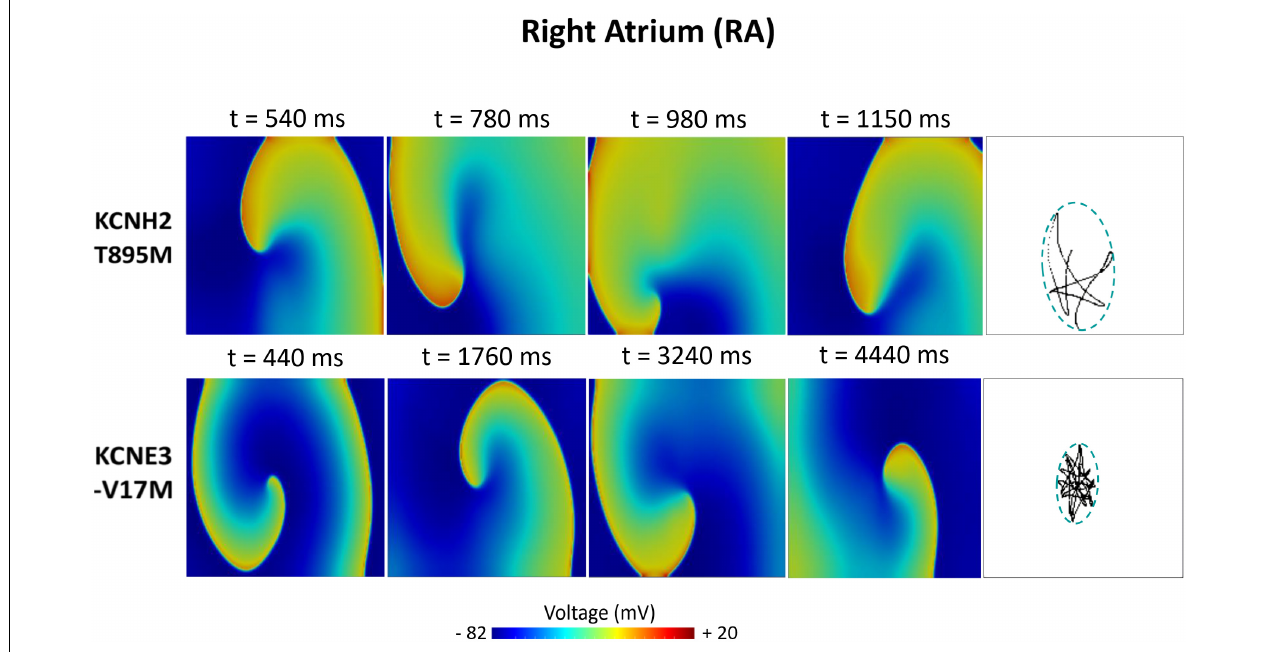
FIGURE 6 | Simulation of spiral waves in 2D right atrium affected by the KCNH2 T895M and KCNE3-V17M mutations. Color-coded voltage snapshots of the rotors and rotors’ tip trajectory enclosed by an ellipse for the quantification of the meandering rotor’s area. S1–S2 interval for KCNH2 T895M model was 241 ms. WT and KCNH2 T436M cases are not shown since no rotors were